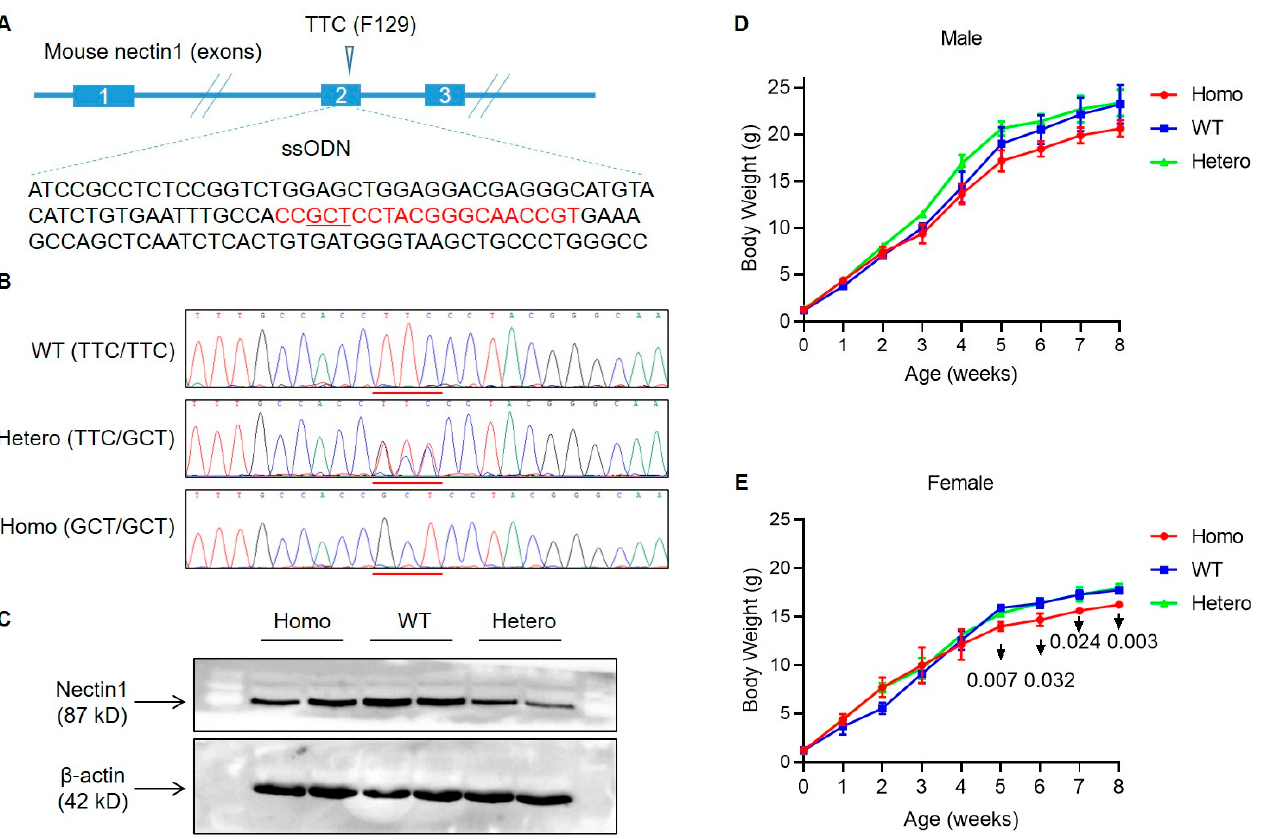
Figure 1. Characterization of nectin1 (F129A) mutant mice. ( A ) Gene targeting strategy to introduce F129A mutation in mouse nectin1. Sequences in red letters are gRNA-recognized target harboring F129A mutation (underlined sequences). ( B ) Sequences of nectin1 mutation site in homozygous, heterozygous, and WT mice. The underlined sequences are F129 mutation sites. ( C ) Nectin1 expression status in brain tissues of homozygous, heterozygous, and WT mice. ( D , E ) Growth curves of male ( D ) and female ( E ) F129A mutant mice. Female homozygous mutant mice had significantly reduced body weight compared with WT littermates at five, six, seven, and eight weeks. Data are presented in mean ± standard deviation. p -values represent homozygous versus WT and were analyzed with one-way ANOVA followed by Dunnett’s multiple comparison test. ssODN, single-stranded oligodeoxynucleotides; Homo, homozygous nectin1 (F129A) mutant mice; Hetero, heterozygous nectin1 (F129A) mutant mice; WT, wild-type